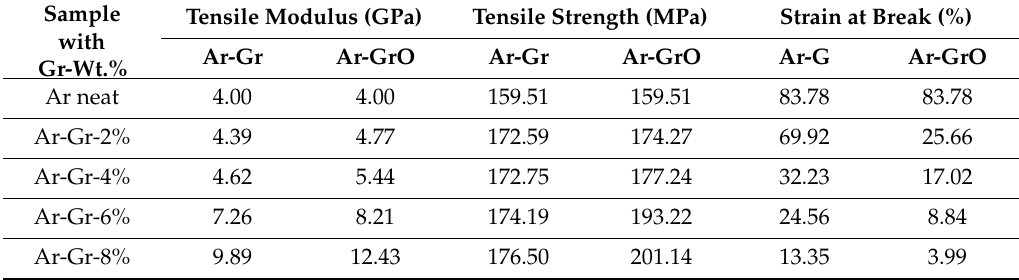
Table 1. Tensile Properties of Ar-Gr and Ar-GrO Composites.